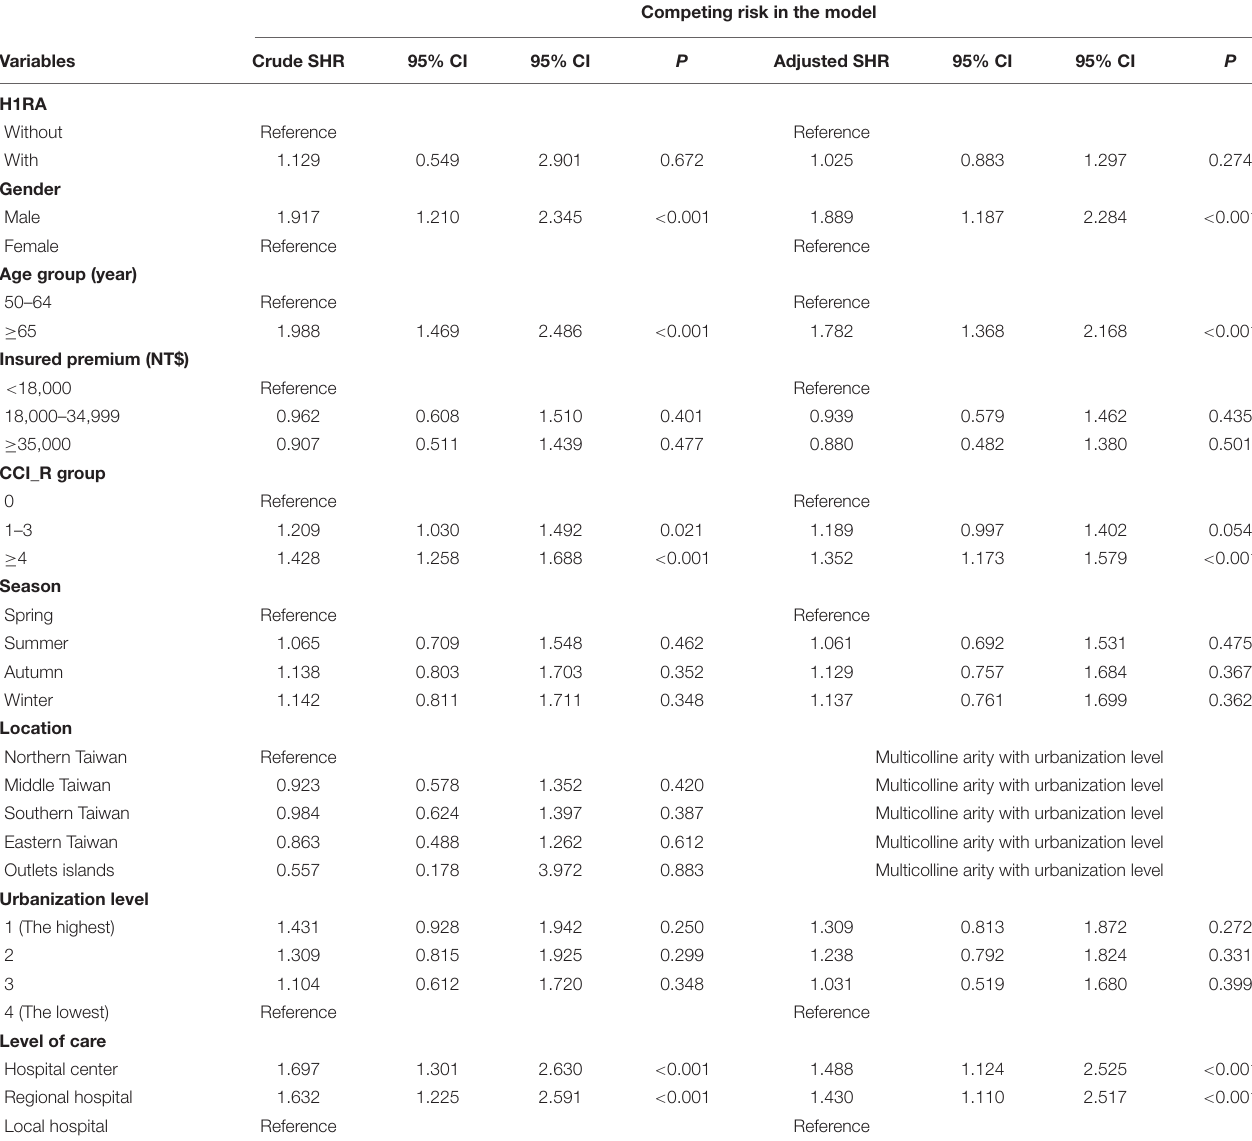
Competing risk in the